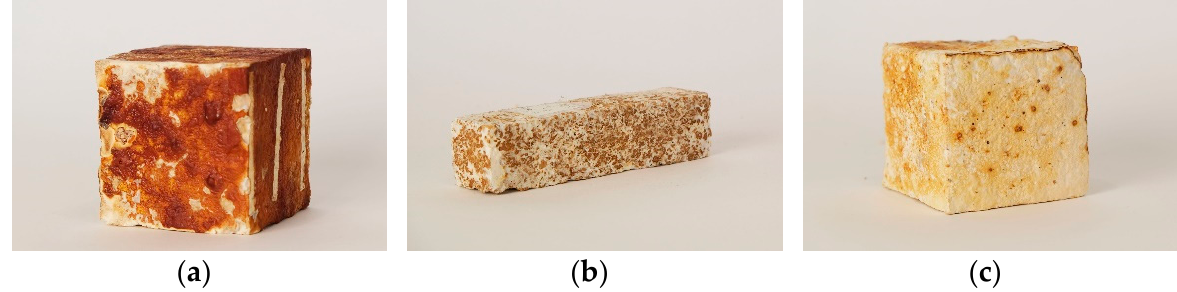
Figure 1. Samples composed of various materials: ( a ) cellulose pulp and clay; ( b ) beech sawdust and clay; ( c ) oak sawdust.